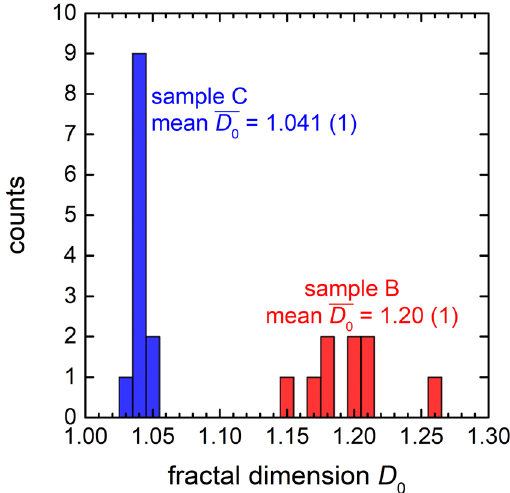
Figure 3. Frequency histogram of the box-counting fractal dimension D 0 of the grains displayed in Fig. 1(b) and (c). The red histogram bars correspond to the fractal grain morphologies of the nanocrystalline sample following heat treatment (Fig. 1(b)), whereas the blue bars derive from the conventional polycrystalline microstructure prepared by solidification from the melt (Fig.